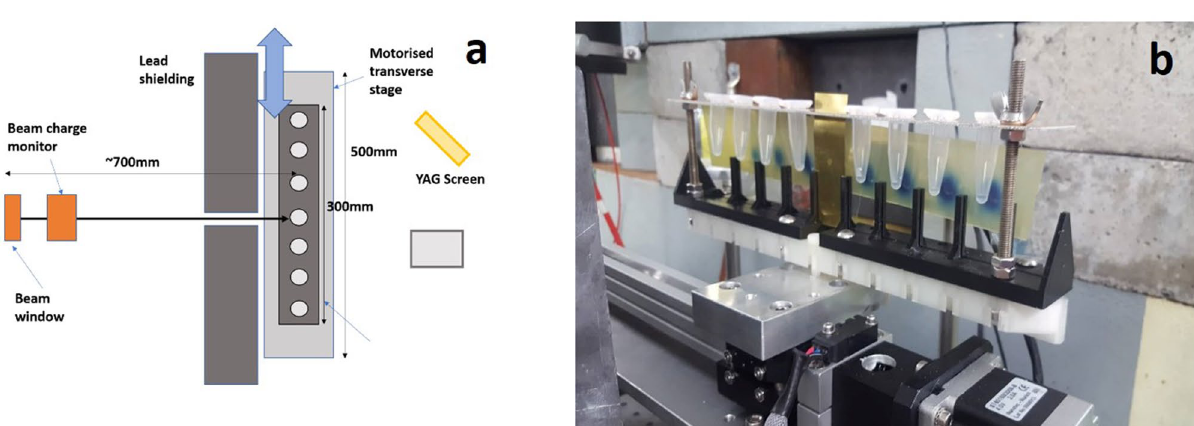
Figure 7. ( a ) Schematic (produced by author K.L.S. and ( b ) photograph (taken by author K.L.S.) of experimental set-up for irradiation of wet plasmid samples in Eppendorf tubes. EBT-XD film placed behind samples to determine dose delivered to